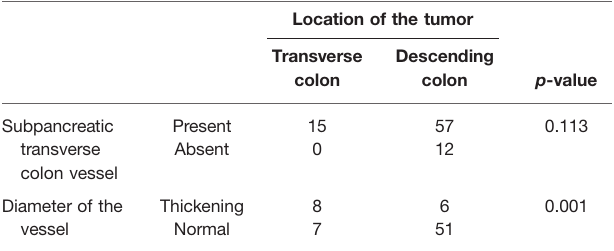
TABLE 2 | Relation between the condition of subpancreatic transverse colon vessel and its diameter and location of the